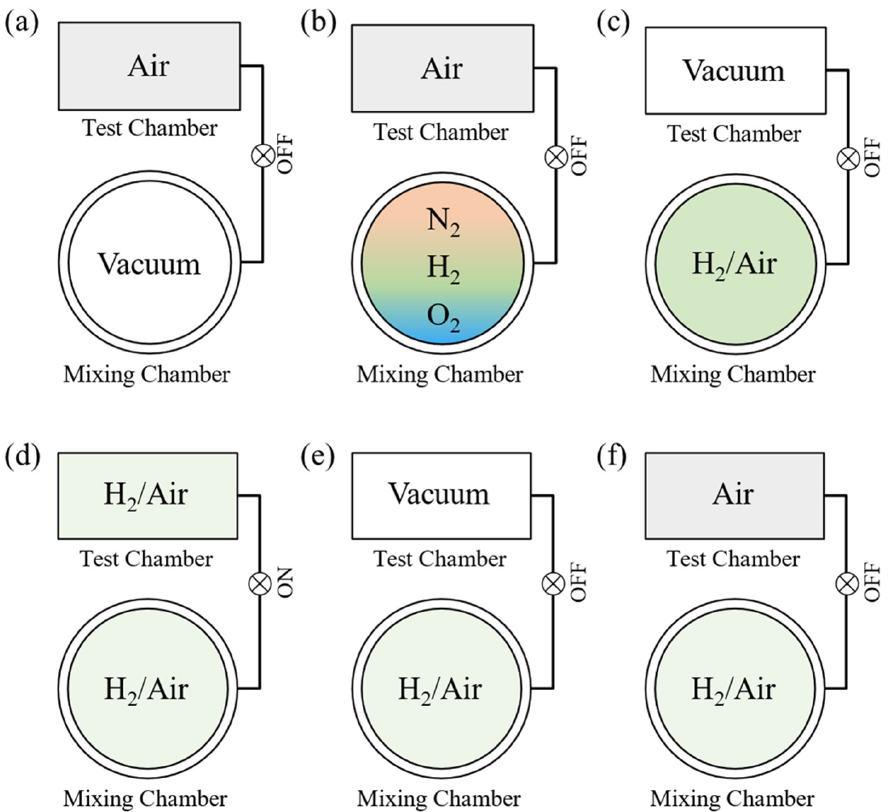
Figure 2. Schematic diagram of environmental gas control strategy. ( a ) shows the evacuation of the mixing chamber Schematically, while ( b ) depicts the gas mixing process, actually different gases are injected chronologically. ( c ) As soon as the target gas is prepared, the test chamber is evacuated. ( d ) Then the valve between mixing chamber and test chamber is opened to inject the target gas. ( e ) When the sample signal stabilizes in hydrogen, the test chamber is evacuated again, ( f ) then synthetic air is injected into the test chamber for recovery curve.